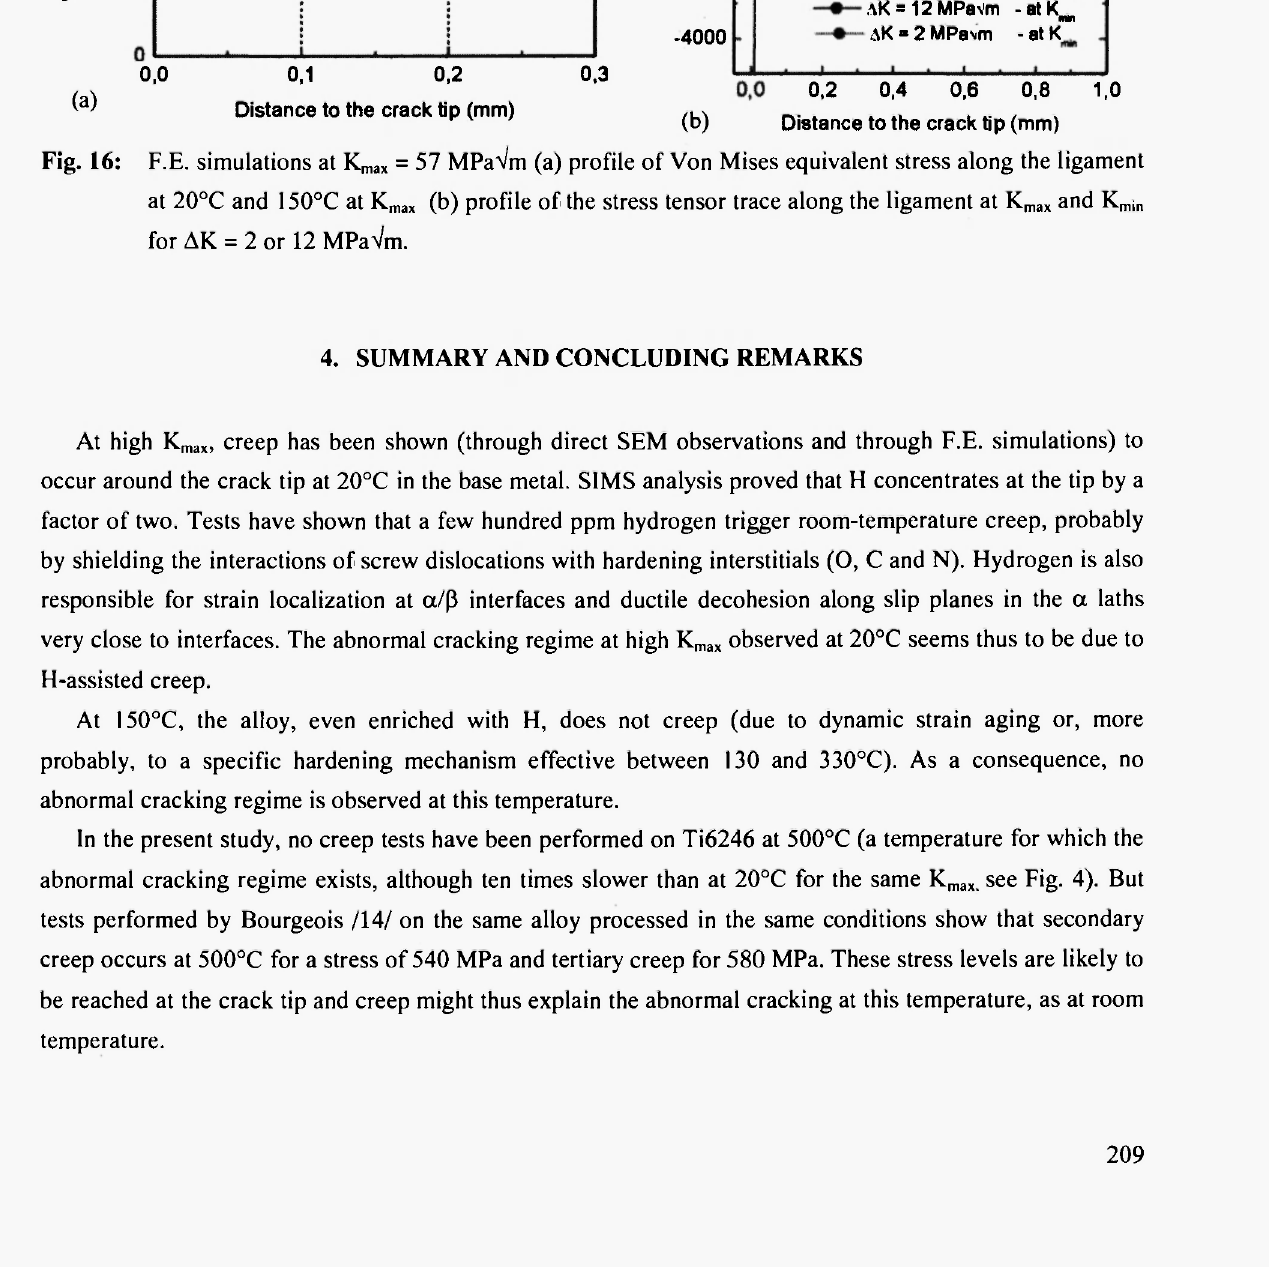
Distance to the crack tip (mm)